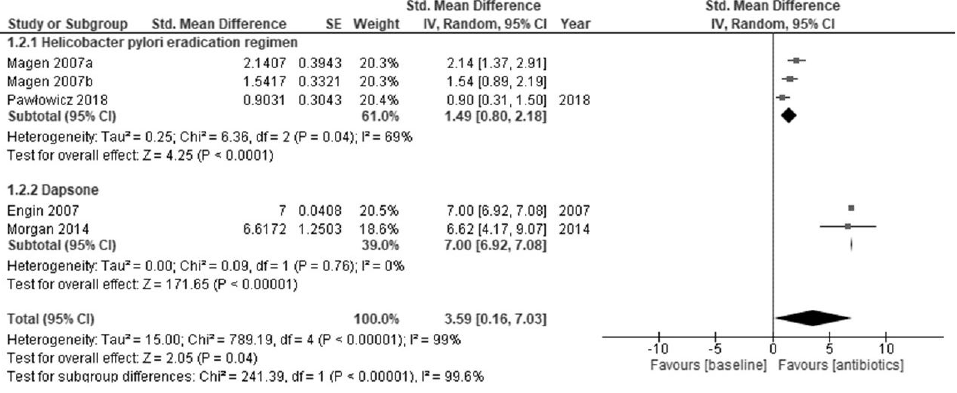
Figure 3. Forest plot of the clinical improvement in antibiotics.